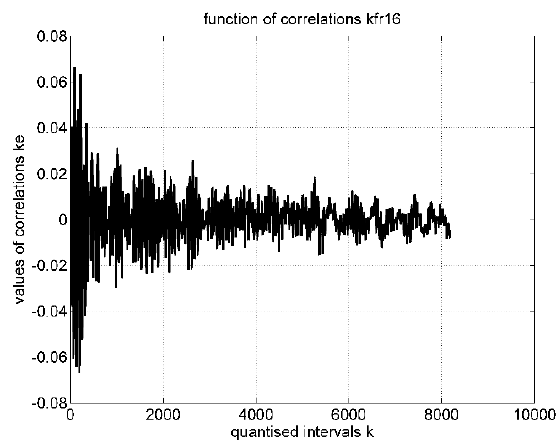
Figure 8. Normalized inter-covariance function of the 1st and 2nd vibration accelerations vectors.